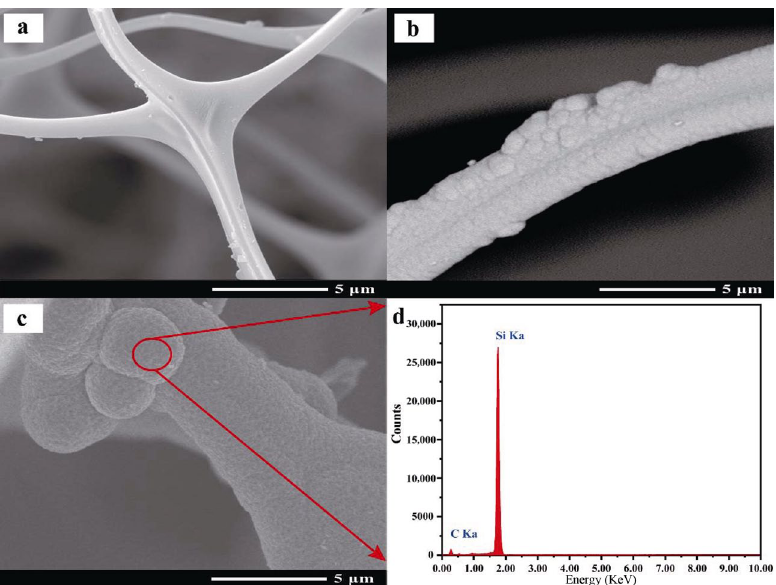
Fig. 4 Microstructure characterization of (a) MDCF, (b) 3D-SiC/MDCF-I, (c) 3D-SiC/MDCF-II under high magnification, and (d) energy-dispersive X-ray spectrometer of agglomerated particles.